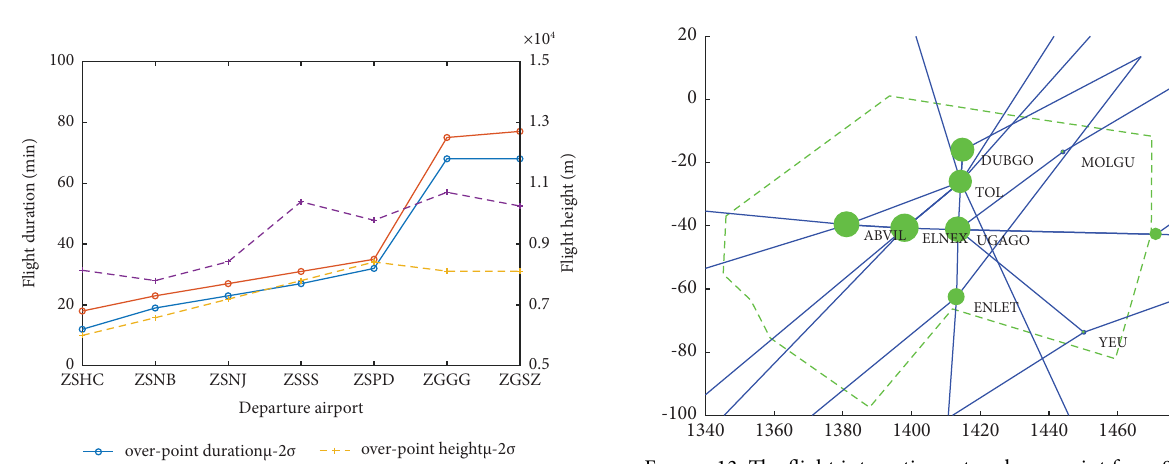
Figure 13: Te fight interactions at each waypoint from 8:00 to 8: